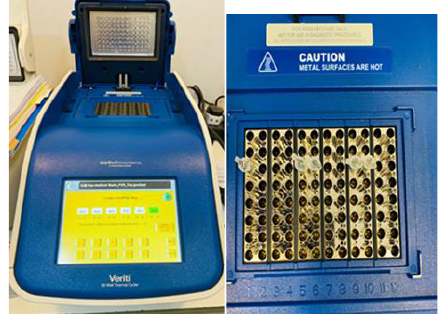
Figure 1: The green master mix and primers